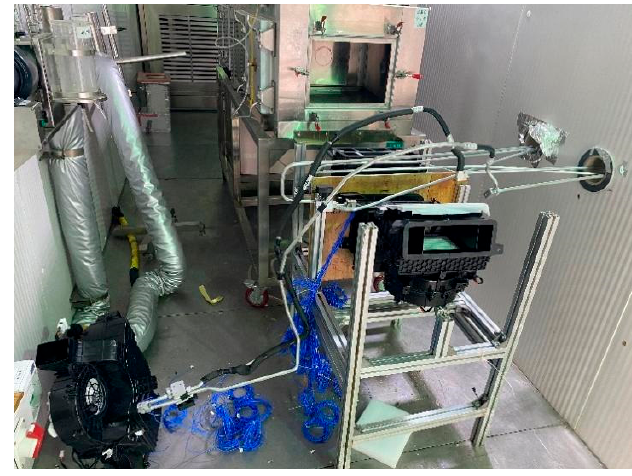
Figure 2. Outdoor chamber.